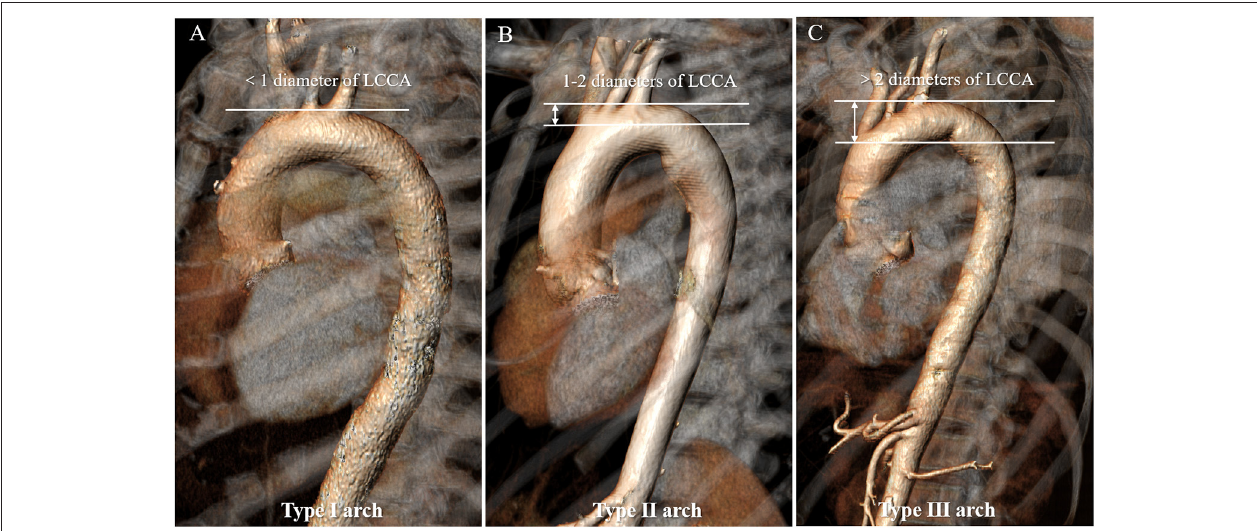
FIGURE 2 | Aortic arch classification in types I to III of the normal aorta. (A) Type I arch: the vertical distance from the origin of the BCT to the vertex of the arch is < 1 time diameter of the LCCA; (B) Type II arch: the distance is between 1 and 2 times the LCCA diameter; (C) Type III arch: the distance is more than 2 times the